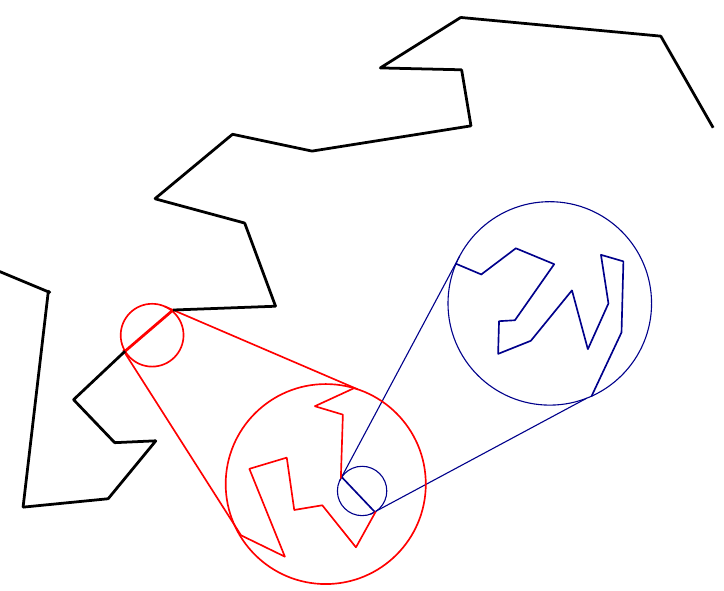
Figure 2. The schematic depicts fractal properties of polymer chains and simultaneously outlines the principle of coarse-graining modelling of polymers, illustrating thus the linkage between the simplifying model assumptions and the real behaviour.